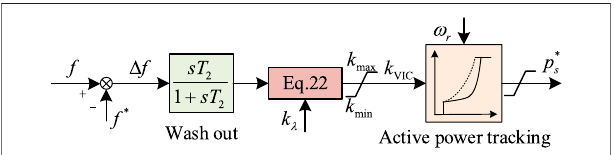
FIGURE 5 | Virtual inertial control structure diagram.